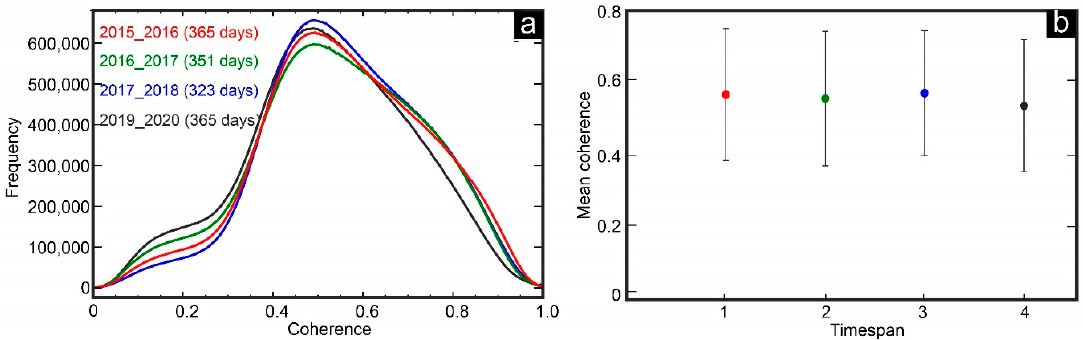
Figure 5. ( a ) Statistical results of coherence changes for SAR pairs with nearly one year time span, and ( b ) mean coherence values of four time spans.